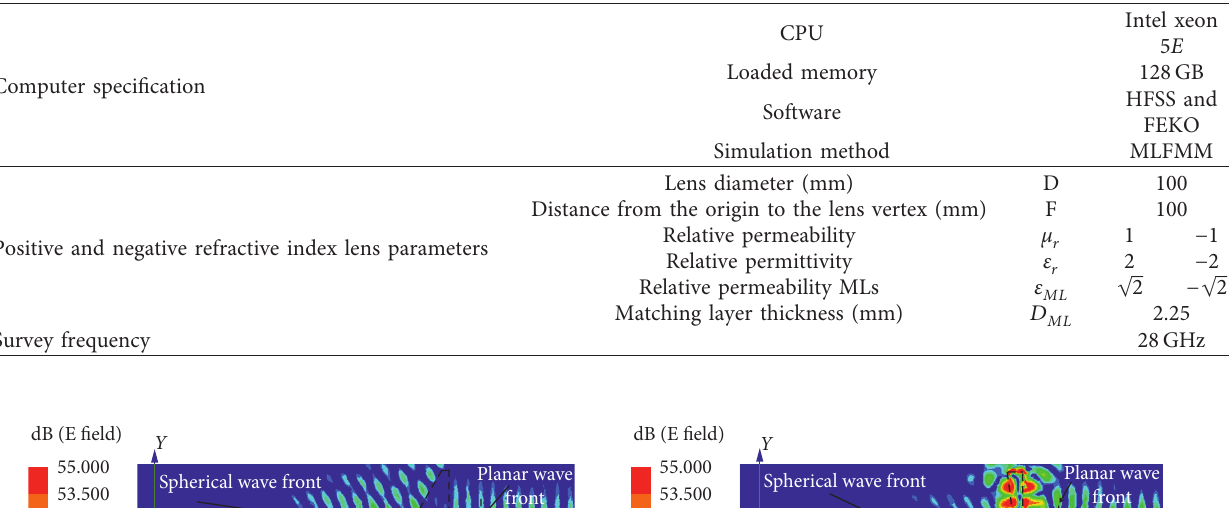
Figure 5: The electric field distributions on the yz plane. (a) PRI lens antenna ( n � antenna ( n �